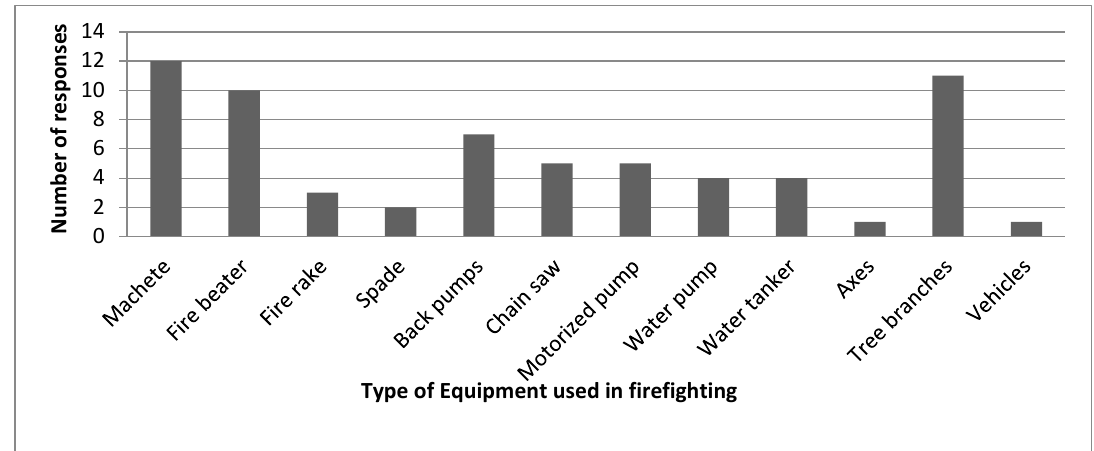
Figure 5. Type of equipment used to fight fires at Gathiuru Forest Station (N =